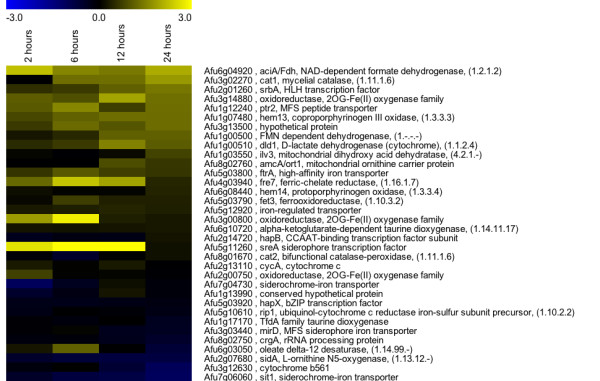
Hypoxia increases transcript levels of enzymes involved in heme biosynthesis, iron-associated and SreA-associated processes. Microarray datasets include three biological and two technical replicates to create heat maps using a median values to compare wild type Aspergillus fumigatus strain CBS144.89 at the indicated times after exposure to hypoxia to time point immediately prior to hypoxia exposure (0 hours). Yellow indicates transcript level is higher under exposure to hypoxia. Data are sorted by the late time point (24 hours post exposure to hypoxia).